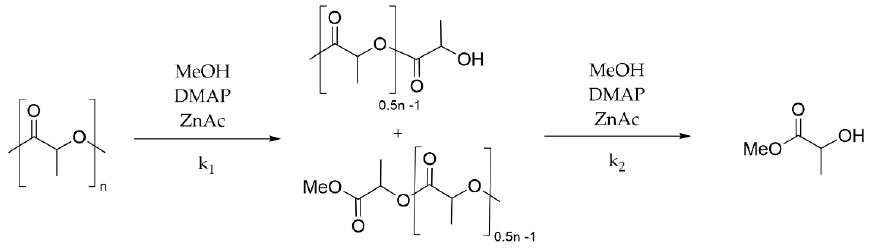
Figure 7. Reaction scheme for methanolysis of PLA, using DMAP and ZnAc as